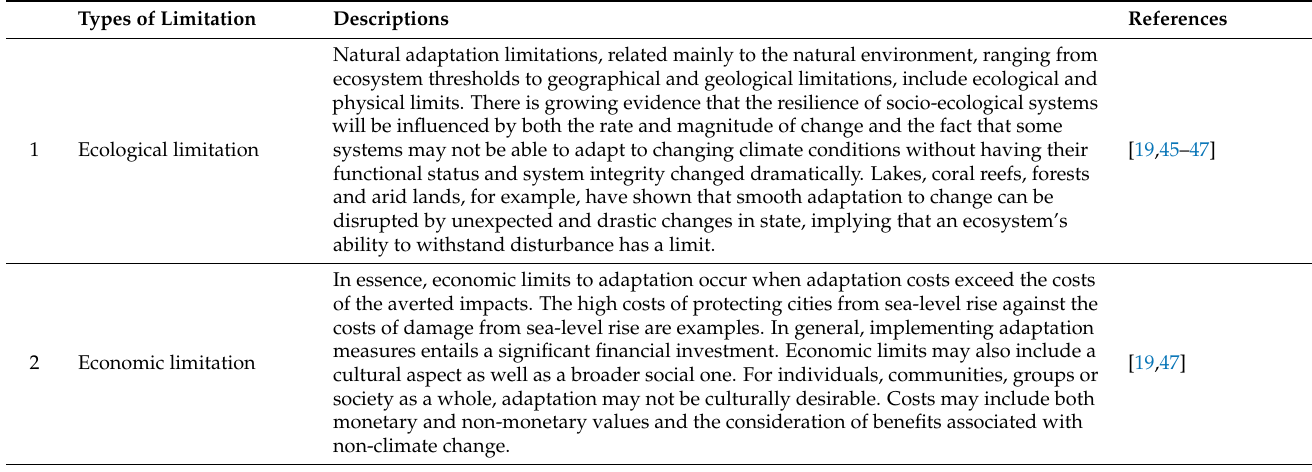
Table 1. Four types of limitations to climate change